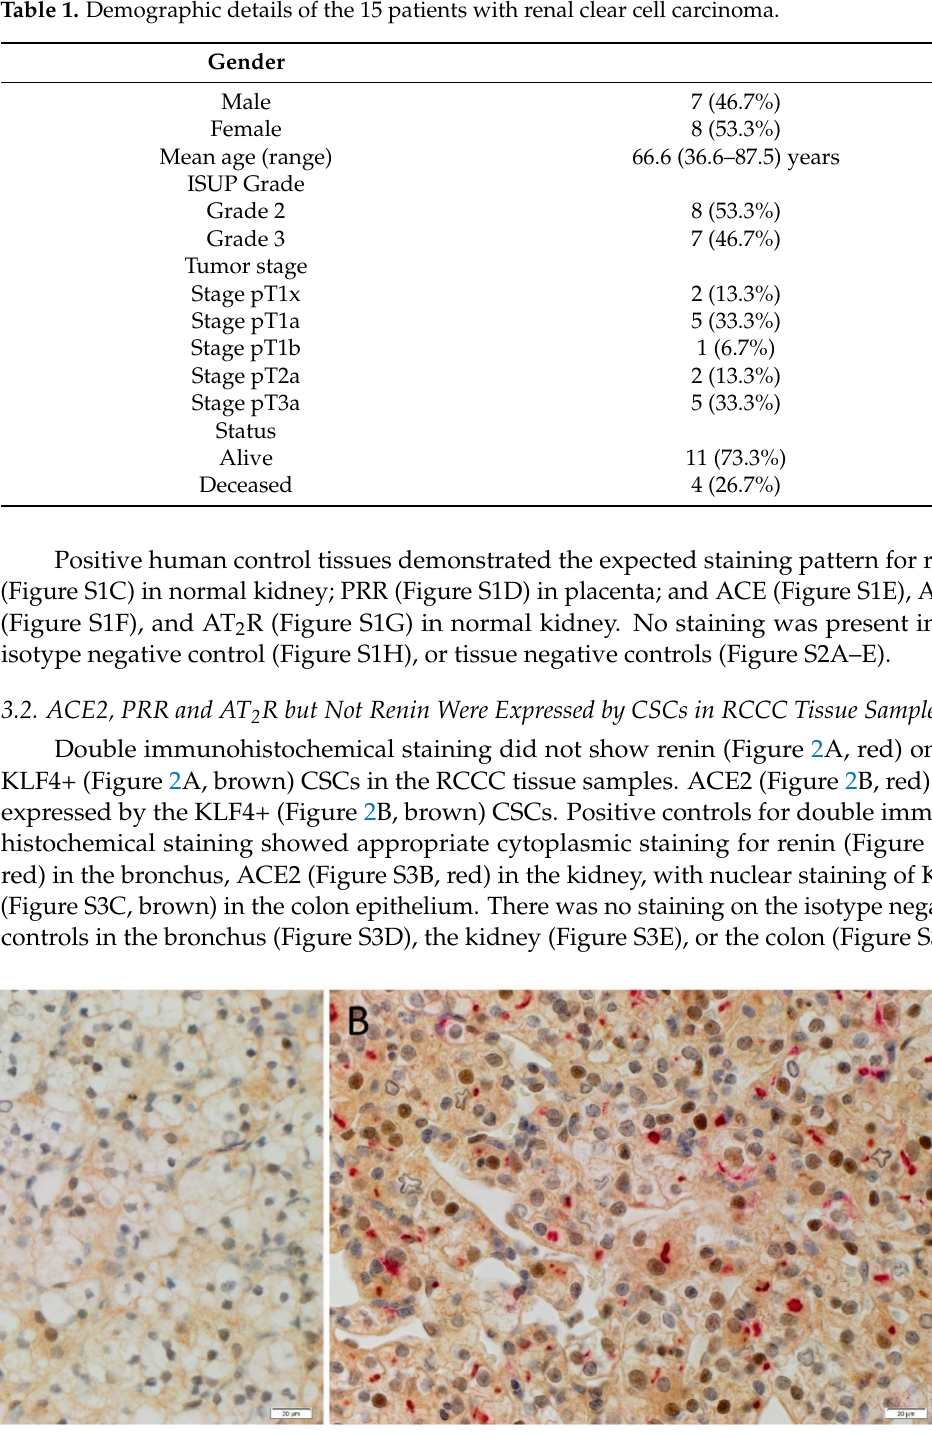
Figure 2. Representative double immunohistochemical stained images demonstrating no expression of renin ( A , red) and expression of ACE2 ( B , red) on the KLF4+ ( A , B , brown) CSCs. Nuclei were counterstained with hematoxylin ( A , B , blue). Original magnification: 400 × . Scale bar: 20 µ